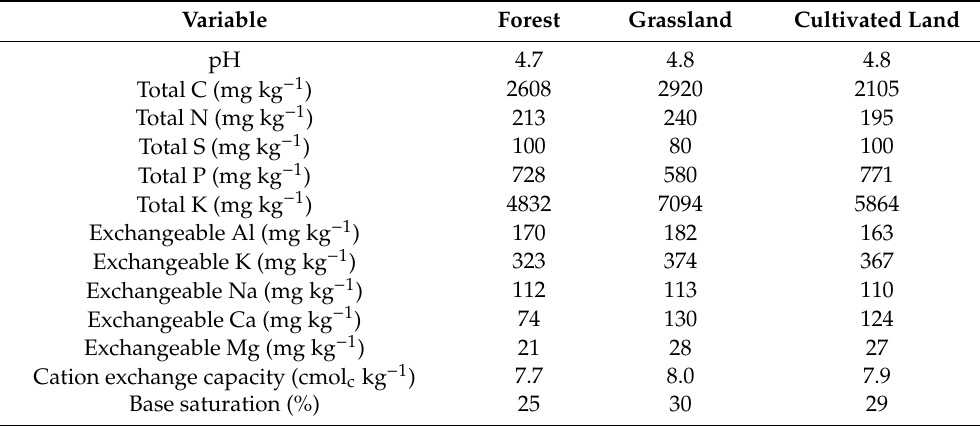
Table 2. Selected mean soil properties (Ultisols) in the Nongkrem catchment based on